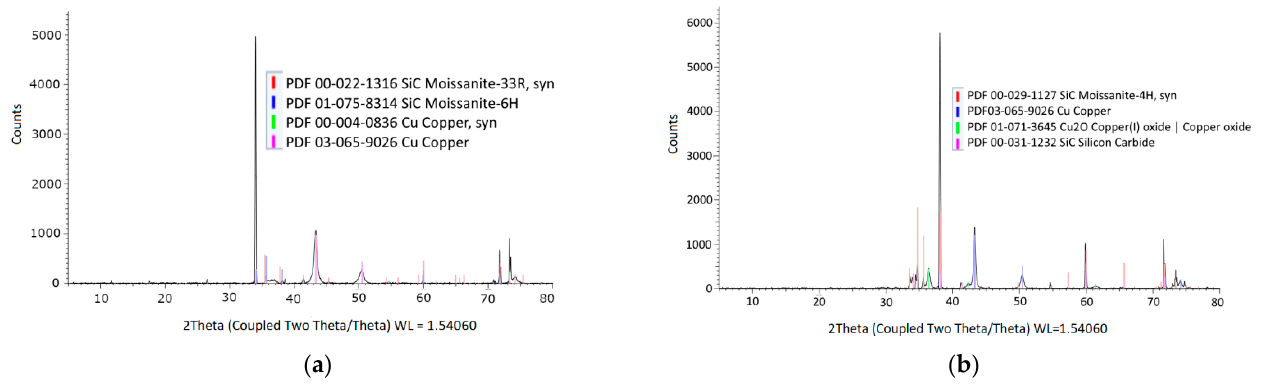
Figure 2. Composite’s structural arrangement. ( a ) 30 min coating time, ( b ) 60 min coating time.